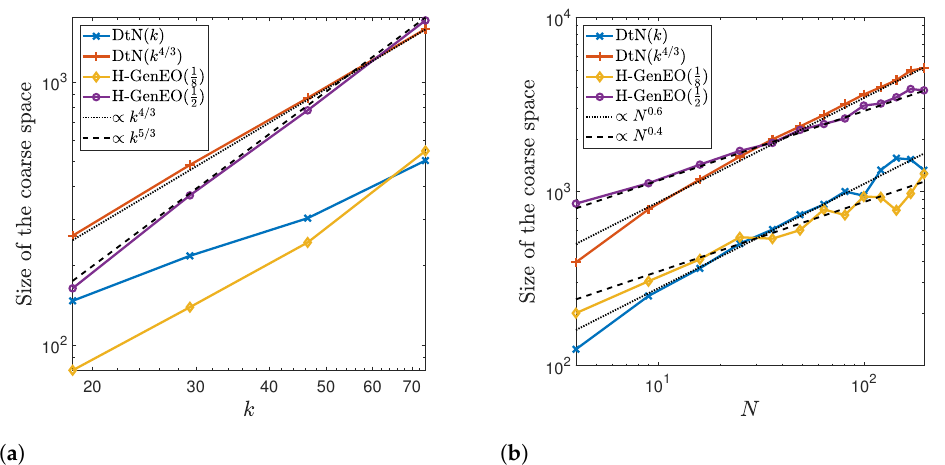
Figure 3. The size of coarse space utilised for the homogeneous problem when using ORAS with the DtN and H-GenEO coarse spaces. A uniform decomposition into is used. ( a ) Varying the wave number k for N = 25, ( b ) Varying the number of subdomains N for k =